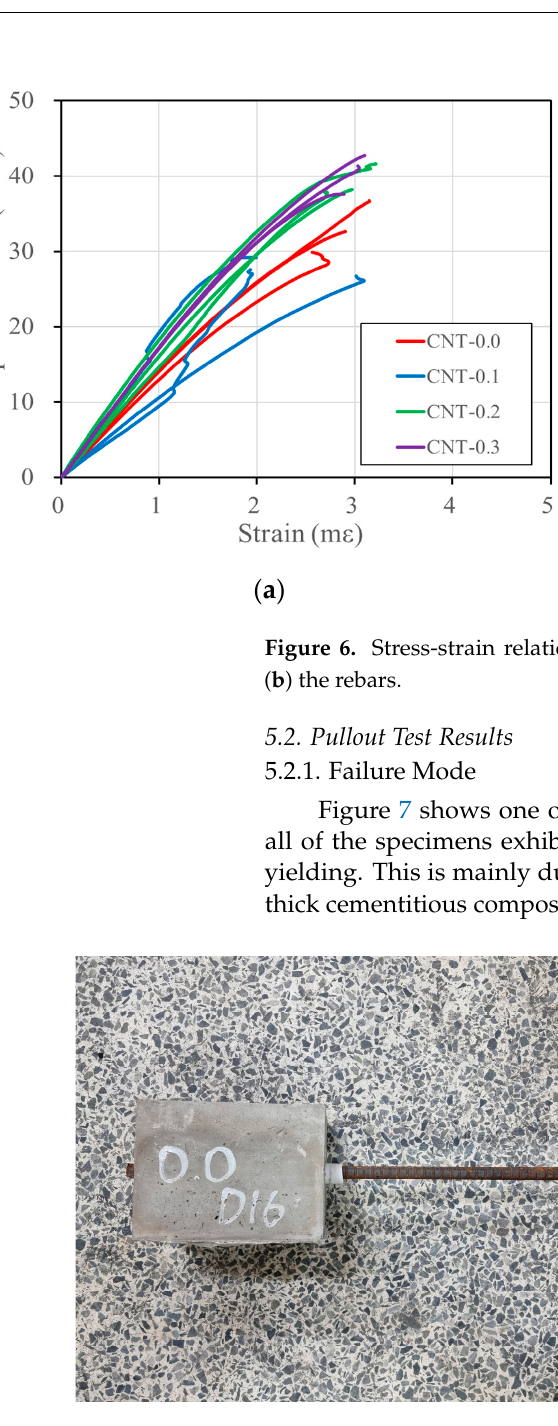
8 of 20 Figure 5. Pull-out test setup. 5. Test Results 5.1. Material Properties Table 6 presents the material properties of the PVA cementitious composites with CNTs. It is noted that the material properties were measured through the compression test, which followed the procedure presented in ASTM C39 [54]. During the compression tests, the strains were measured through two LVDTs attached to the side of the cylindrical specimen so that the modulus of elasticity could be evaluated from the stress-strain re- sponses, as presented in Figure 6a. As presented in the table, it was observed that the